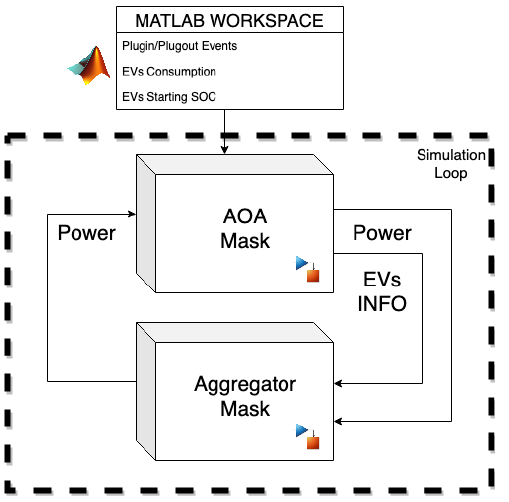
Figure 9. Schematic of the offline simulator architecture. See Figure 1 for a more detailed representa-